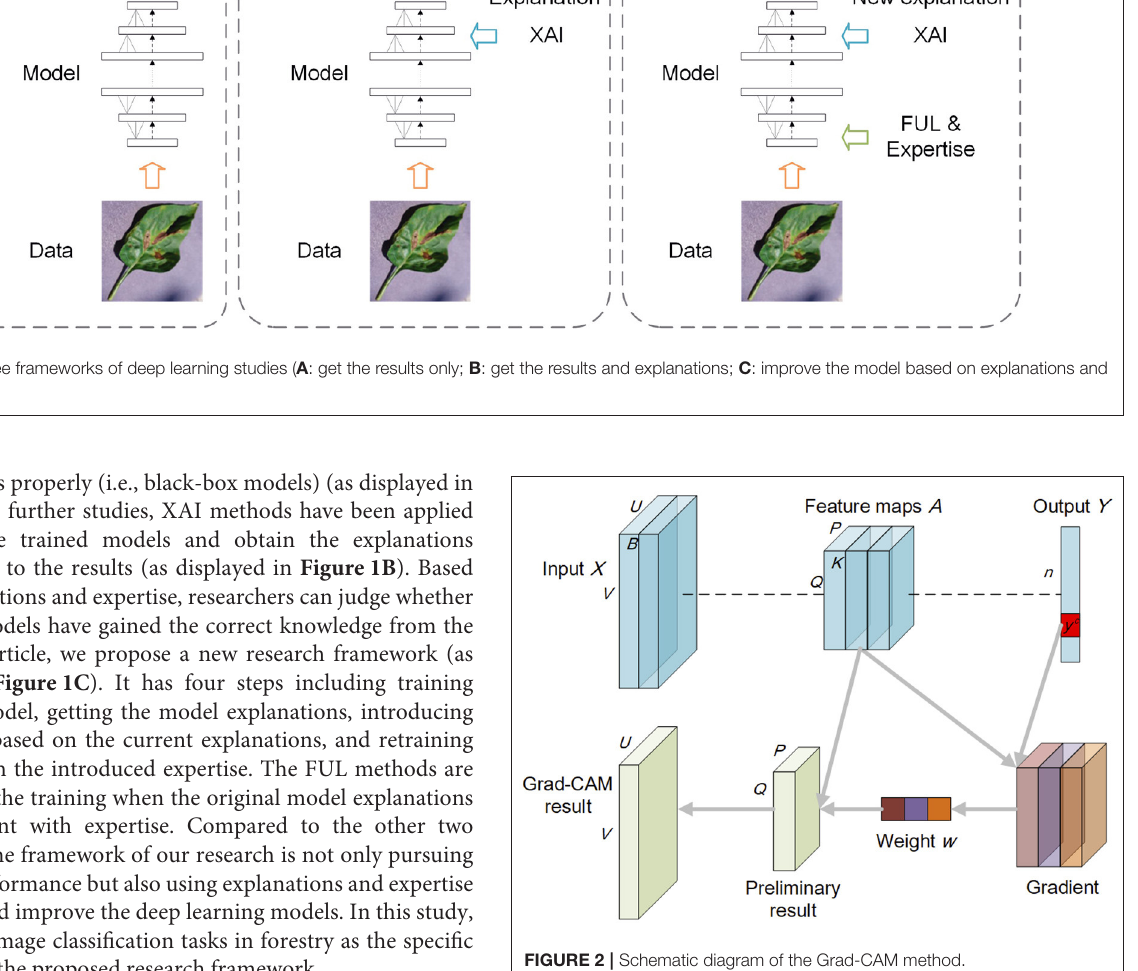
FIGURE 2 | Schematic diagram of the Grad-CAM